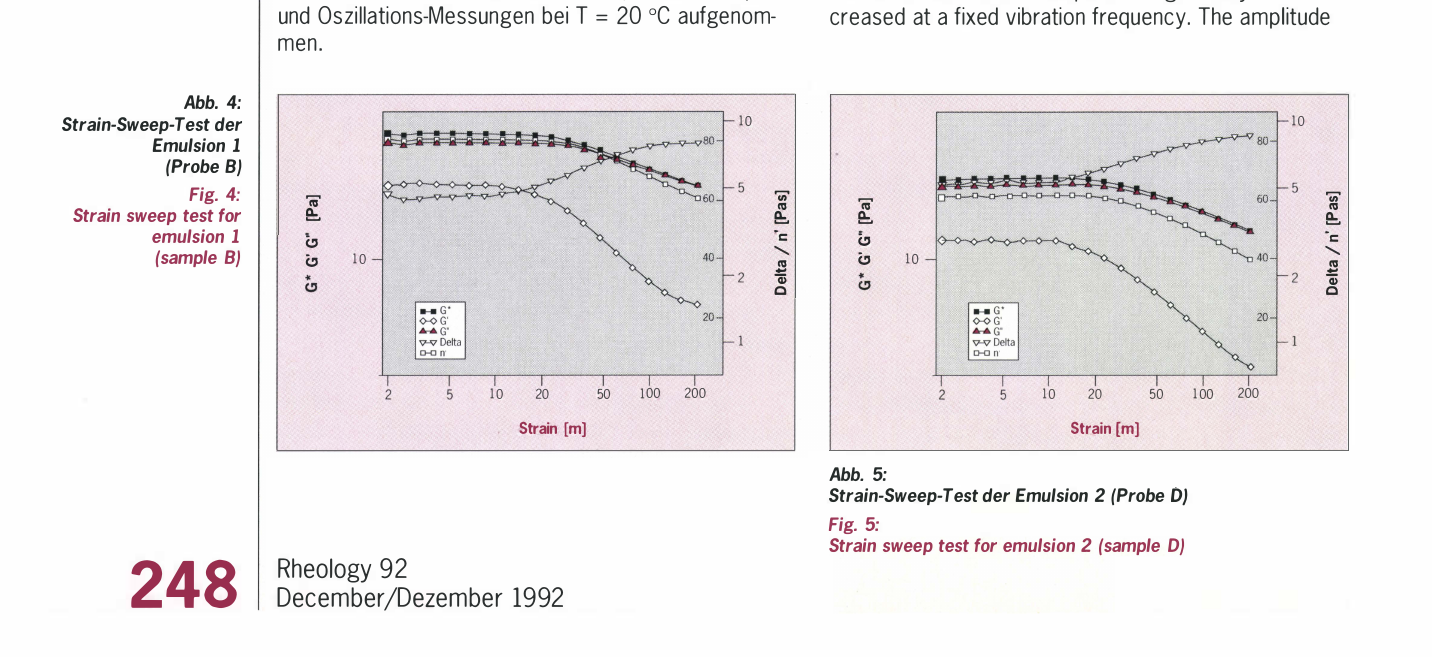
Fig. 4: Strain sweep test for emulsion 1 (sample B)